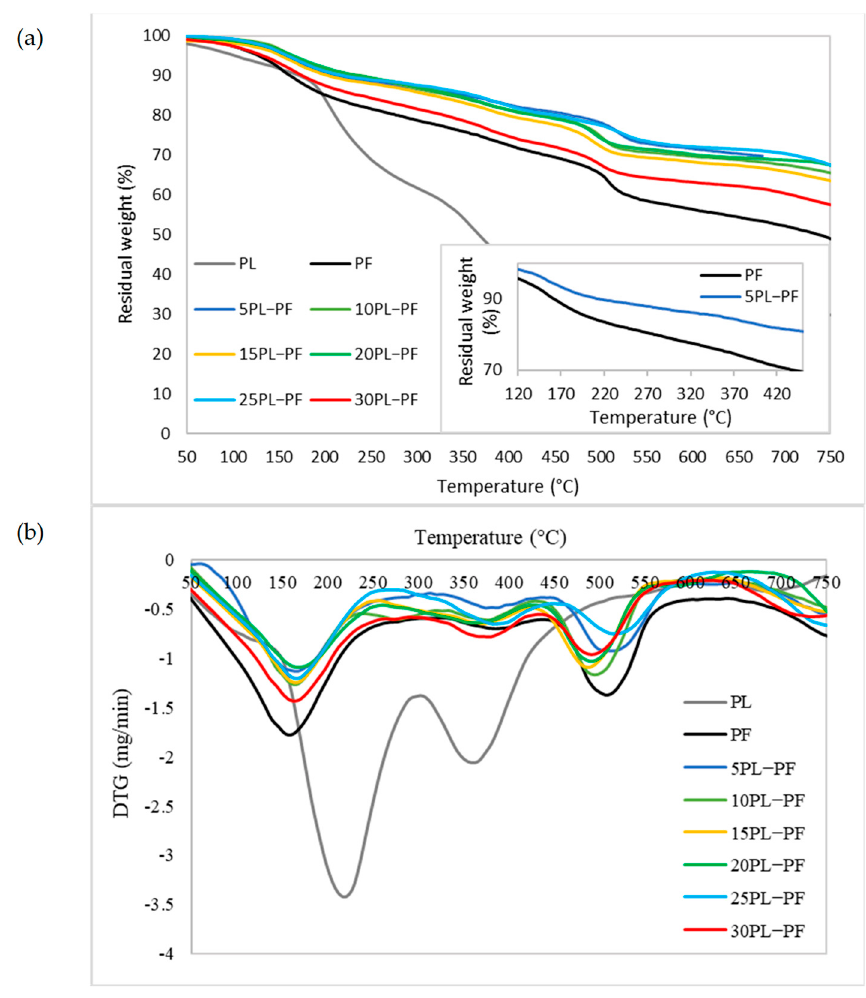
Figure 7. ( a ) TG and ( b ) DTG thermograms of the PL, PF and PL − PF resins with 5 to 30% phenol substitution rate, and the small box showing the TG thermogram of PF and 5PL − PF resins at 160 and 390 °C.